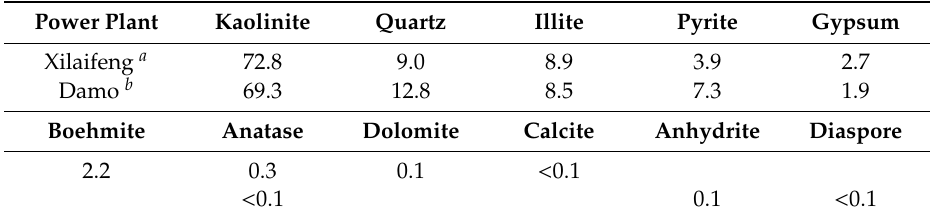
Table 2. Average values of mineralogical compositions of the low-temperature ashes (LTAs) of feed coals (wt.%) for the Xilaifeng and Damo power plants by XRD and Siroquant analysis. Power Plant